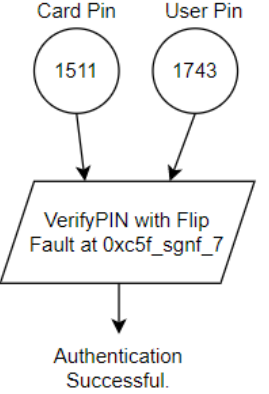
Figure 3. FLP Fault in VerifyPIN Granting Unauthorized Access.